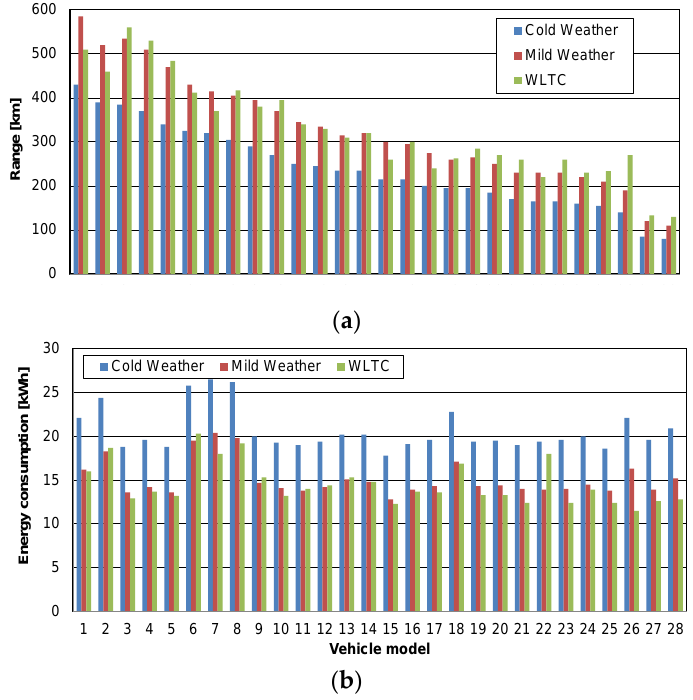
Figure 2. A comparison of the vehicle range ( a ) and the energy consumption ( b ) depending on the weather conditions [3].